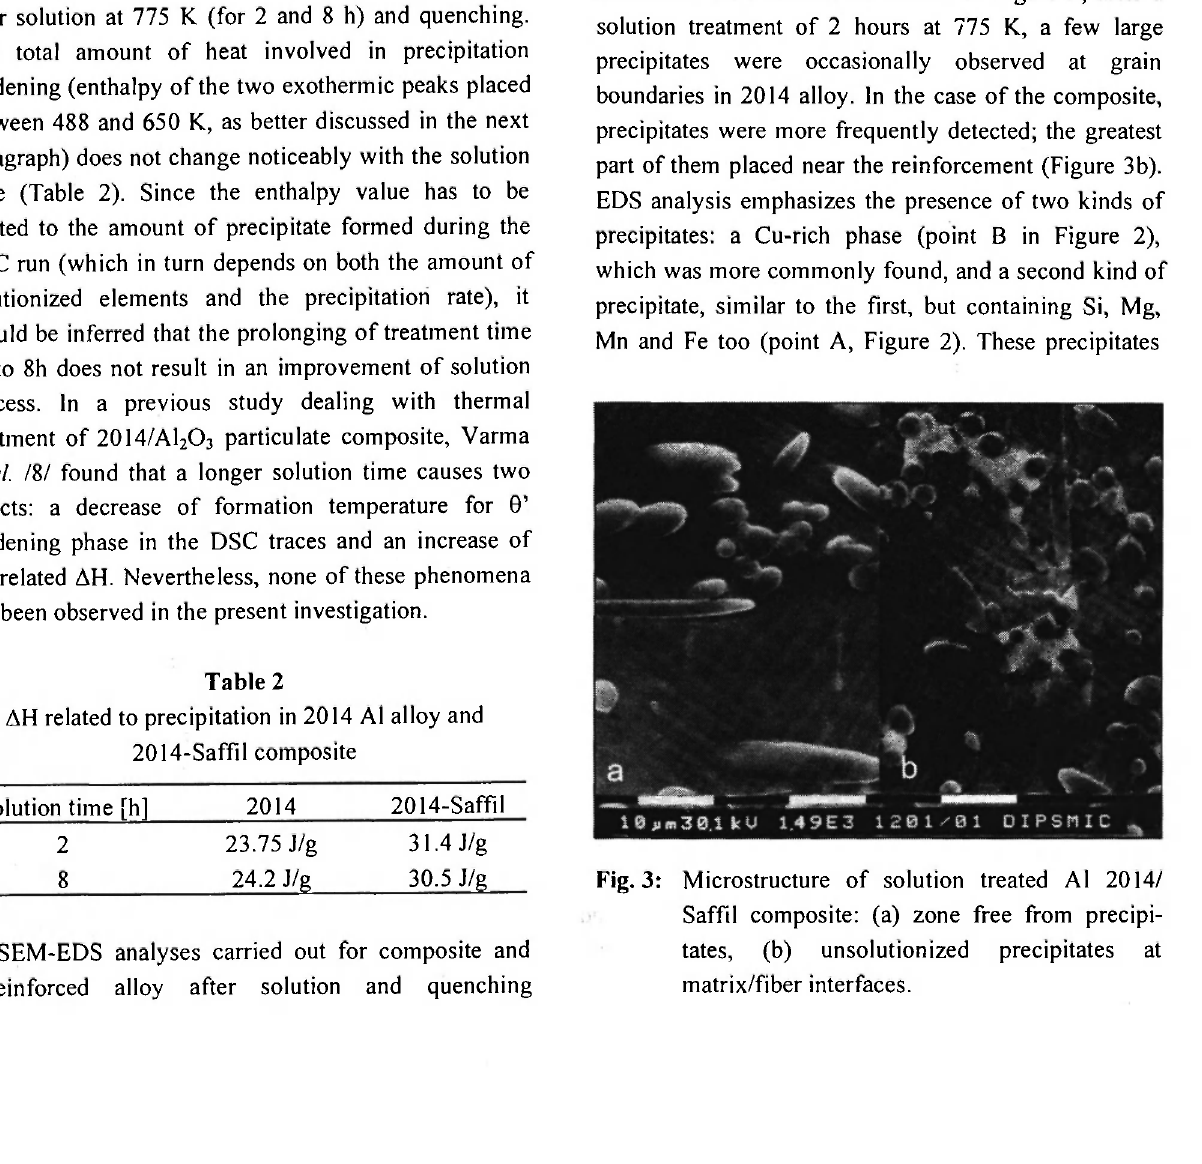
Fig. 2: Precipitates in solution treated Al 2014 alloy.